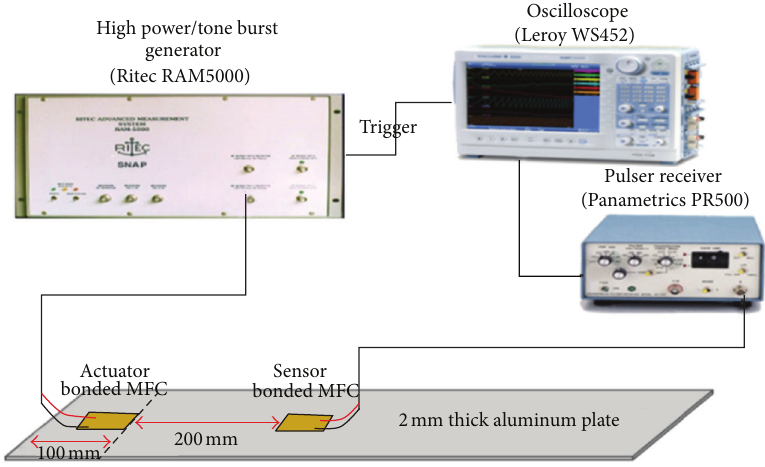
Figure 3: Pitch-catch measurement experiment set-up.